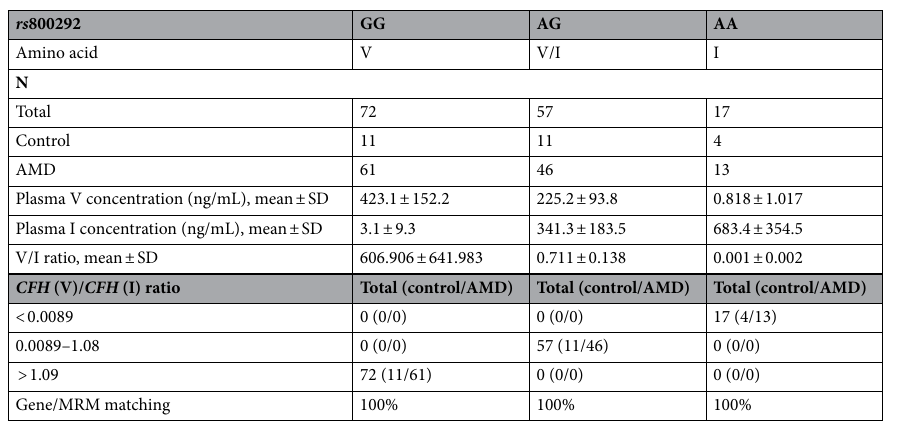
Table 4. The plasma level of complement factor H variants by measuring multiple reaction monitoring assay and distribution, matching according to the genotype of complement factor H single nucleotide polymorphism rs 800292. V, valine; I, isoleucine; AMD, age-related macular degeneration; MRM, multiple reaction monitoring; SD, standard deviation.